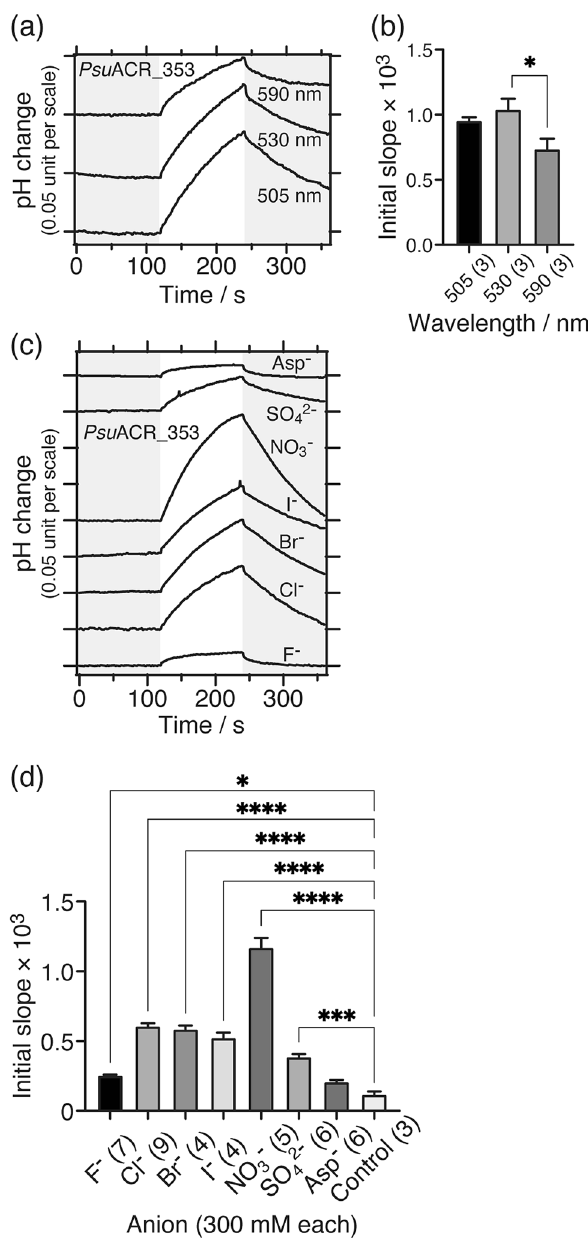
Figure 4. Anion transport activity of Psu ACR_353 measured using the pH electrode method. ( a ) Comparisons of Cl − transport activities at various excitation light wavelengths (10 mW/cm 2 ). LED lights were illuminated for 2 min as shown on a white background. ( b ) Statistical comparisons of Cl − transport activities at various excitation light wavelengths. Data are reported as means and S.E.M.; the numbers in parenthesis indicate the numbers of independent experiments. One-way ANOVA followed by Tukey’s test was performed ( p value; * 0.0471). ( c ) Comparisons of anion-dependent transport activities. 530 nm LED light (10 mW/cm 2 ) was illuminated for 2 min as shown on a white background. ( d ) Statistical comparisons of anion-dependent transport activities. Data are reported as means and S.E.M.; the numbers in parentheses indicate the number of independent experiments. One-way ANOVA followed by Dunnett’s test was performed ( p values; **** < 0.0001, *** 0.0002, * 0.0461). The negative control was yeast cells without integration of the Psu ACR_353 gene resuspended in 300 mM